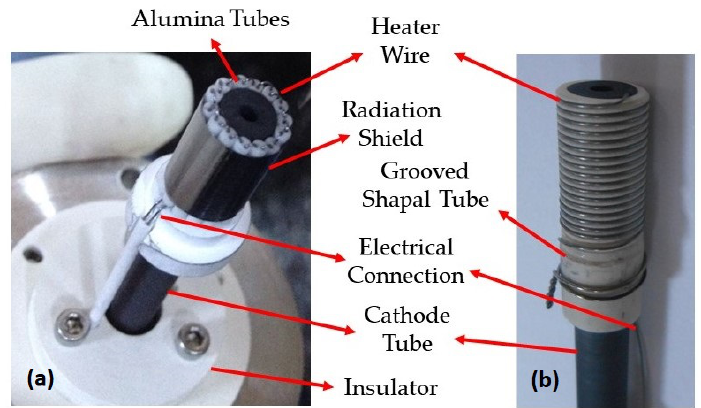
Figure 2. ( a ) First conventional design; ( b ) Second conventional design.